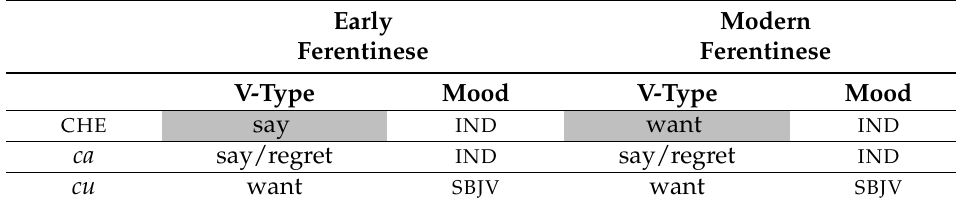
Table 1. Complementizer distribution by matrix predicate type and morphological mood. Early